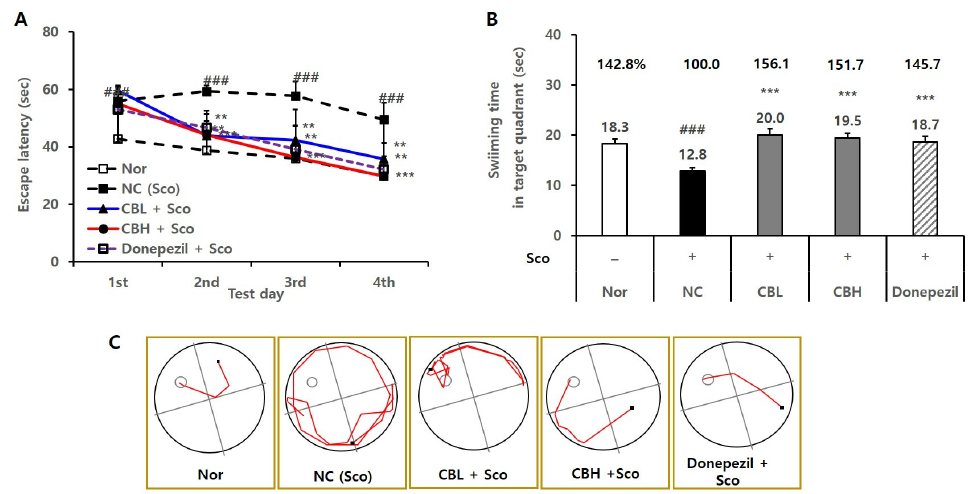
Figure 6. Effects of CB extract on ( A ) the escape latency on days 1–4, ( B ) swimming time on day 5, and ( C ) representative search strategy on day 4 of acutely Sco-treated mice in the Morris water maze test. Mice were randomly divided into five groups. Nor, normal, commercial diet + saline; NC, negative control (Sco), commercial diet + Sco in saline; CBL, 112.7 mg/kg CB extract + Sco in saline; CBH, 328.0 mg/kg CB extract + Sco in saline; Donepezil, commercial diet + 1 mg/kg Donepezil in saline (p.o.) + Sco in saline (n = 10). Sco at 1 mg/kg was administered to the mice one time per day for 5 days (i.p.). Significance was determined by one-way ANOVA with post hoc Tukey’s multiple comparison test. Data are presented as means ± standard errors of the mean (SEM). ### p < 0.001 significance compared with the control (white bar). *** p < 0.001, ** p < 0.01, significance compared with Sco-treated groups (black bar).